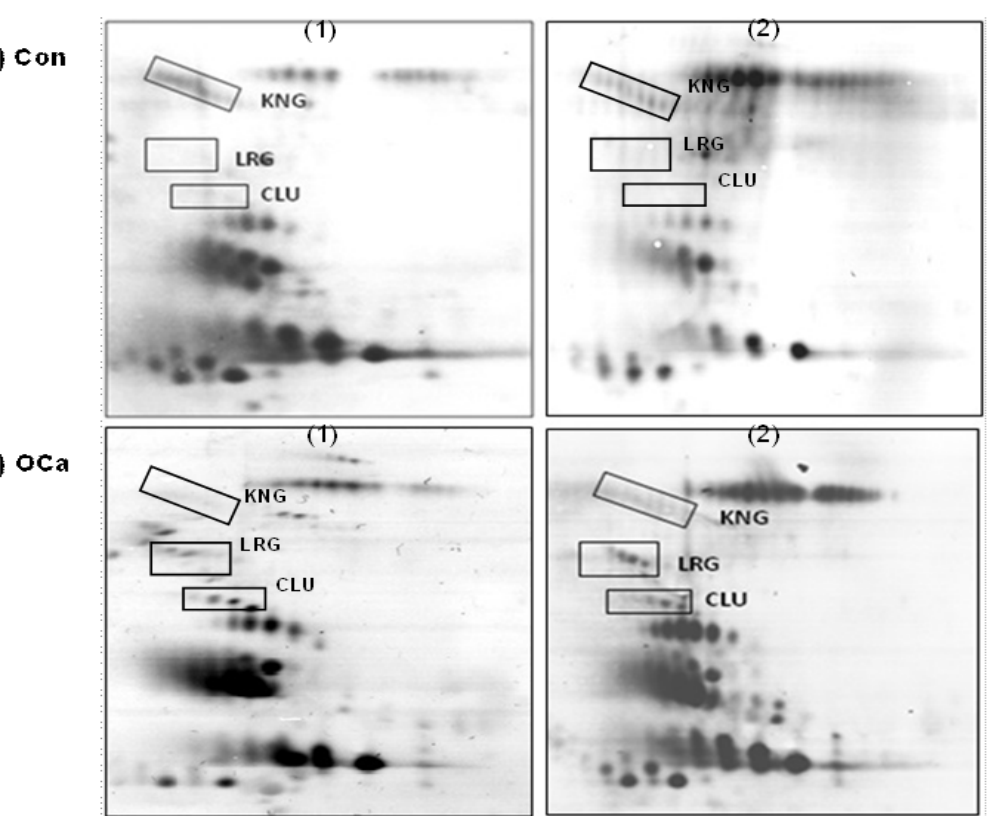
Figure 1. Two-dimensional gel electrophoresis (2-DE) O -glycosylated protein profiles of controls and ovarian cancer (OCa) patients. Panels A and B demonstrate representative 2-DE urinary O -glycosylated protein profiles of controls and OCa patients, respectively. Protein clusters that were labeled (clusterin (CLU), leucine-rich alpha-2-glycoprotein (LRG) and kininogen (KNG)) are those found to be aberrantly excreted in the urine of the patients. The acidic side of the gel is to the left, and relative molecular mass is from the top.